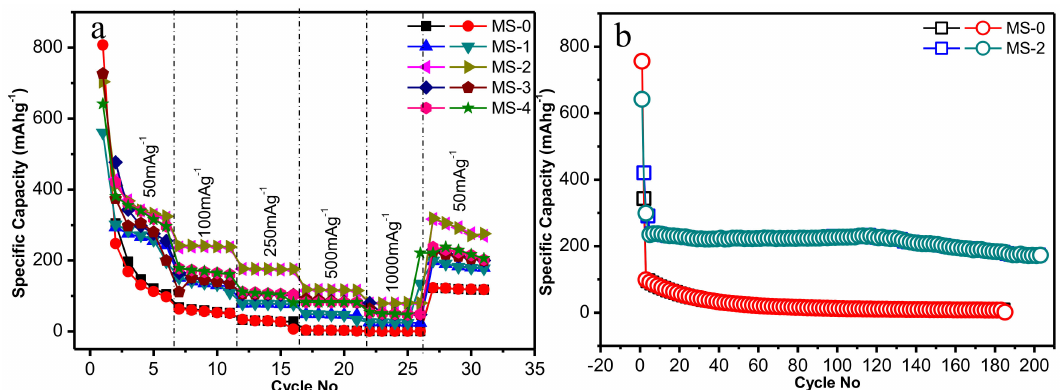
Figure 8. Electrochemical properties: ( a ) the rate performance of all samples at different current densities; and ( b ) the cycling performance of MS-0 and MS-2 between 0.01 and 3 V at a current rate of 200 mAg − 1